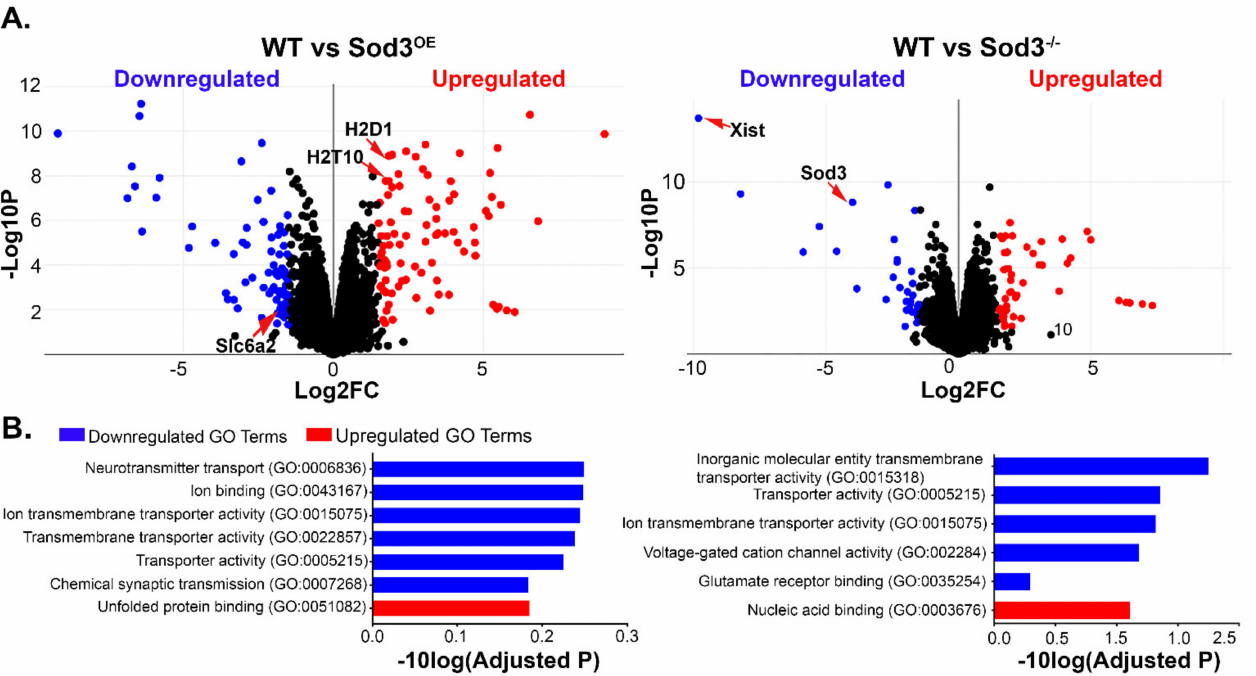
Figure 6. RNA sequencing data uncovers dysregulated processes in mutant animals. ( A ) Volcano plot of downregulated and upregulated genes relative to their log2FC and p -value. ( B ) Top identified GO terms were presented as a function of the − 10log of the adjusted p -value. Blue indicates downregulated terms, while red corresponds to upregulated